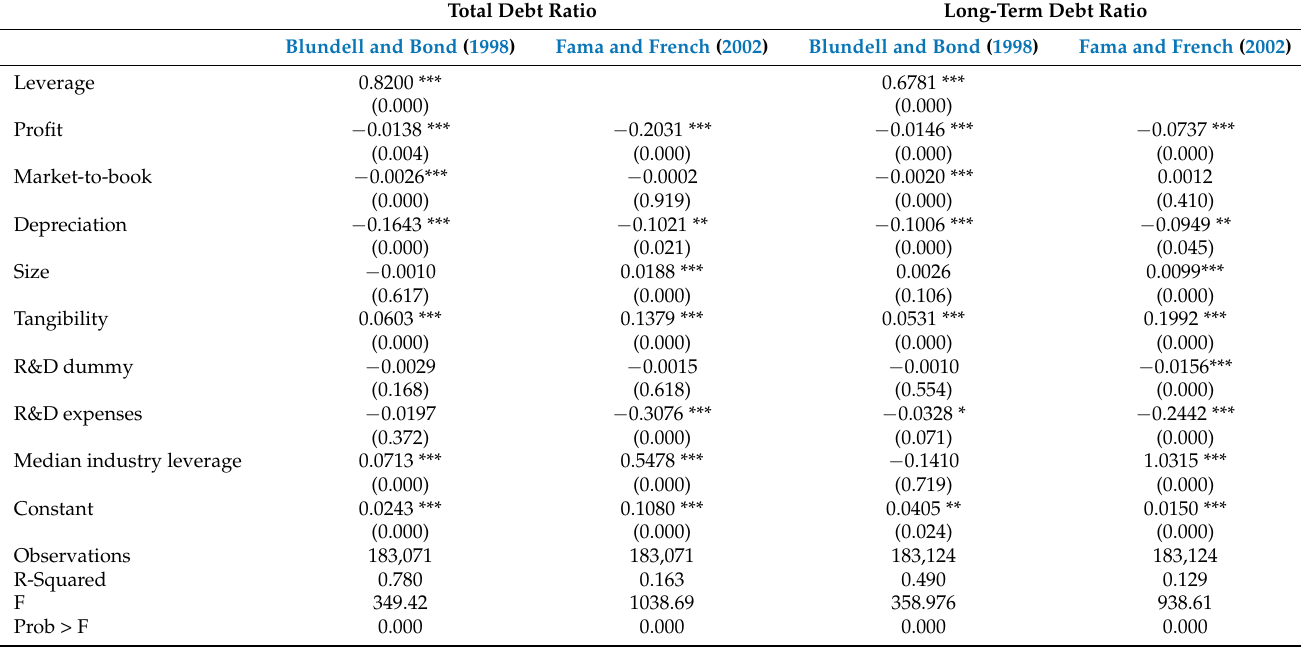
Table 2. Target capital structure